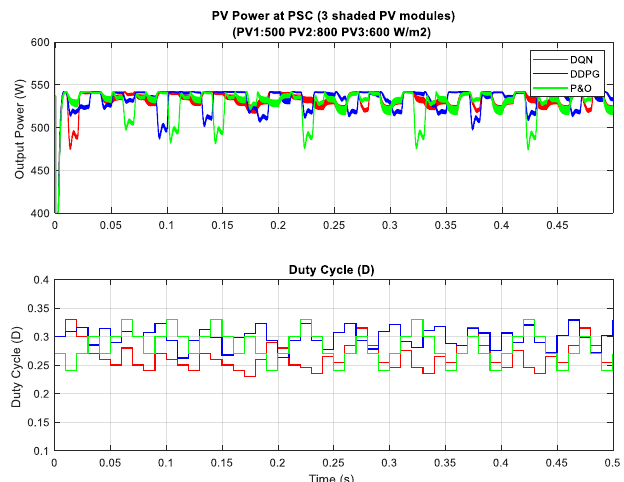
Figure 16. PV power under PSC with three shaded PV modules.